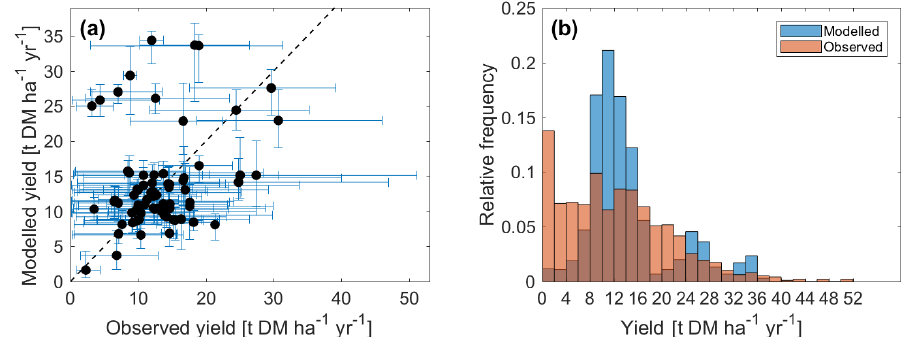
Figure 5. Modelled yields compared to observed yields of Miscanthus collated by Li et al. (2018a). In (a) , the error bars give the range of data at each half-degree grid cell. The observed range (horizontal error bars) accounts for variation between sites (different sites may exist within a grid cell area), years and fertiliser or irrigation treatment; the modelled range (vertical error bars) reflects interannual variability only. Panel (b) shows the range of values by relative frequency. This figure may be compared to Fig. 3e–f from Li et al. (2018b).